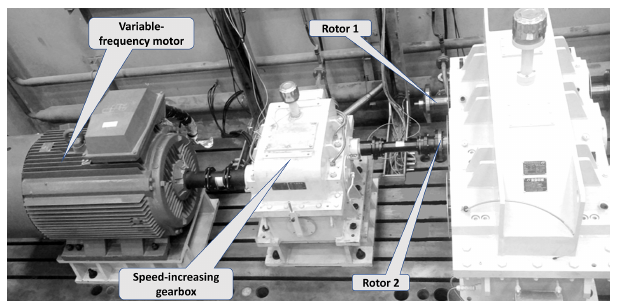
Figure 3. Gear-rotor test bench.